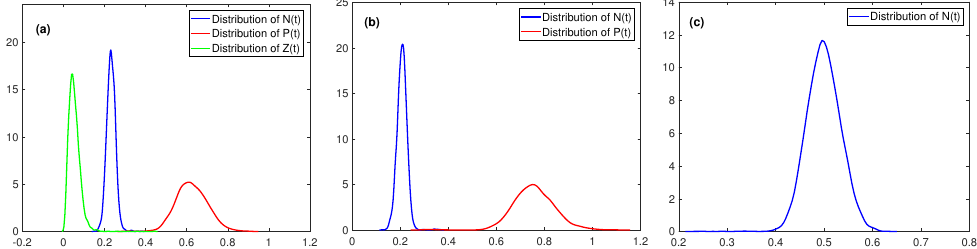
Figure 5. The distributions of N ( t ) , P ( t ) and Z ( t ) , where all parameters in ( a – c ) are the same with these in Figure 1b–d,